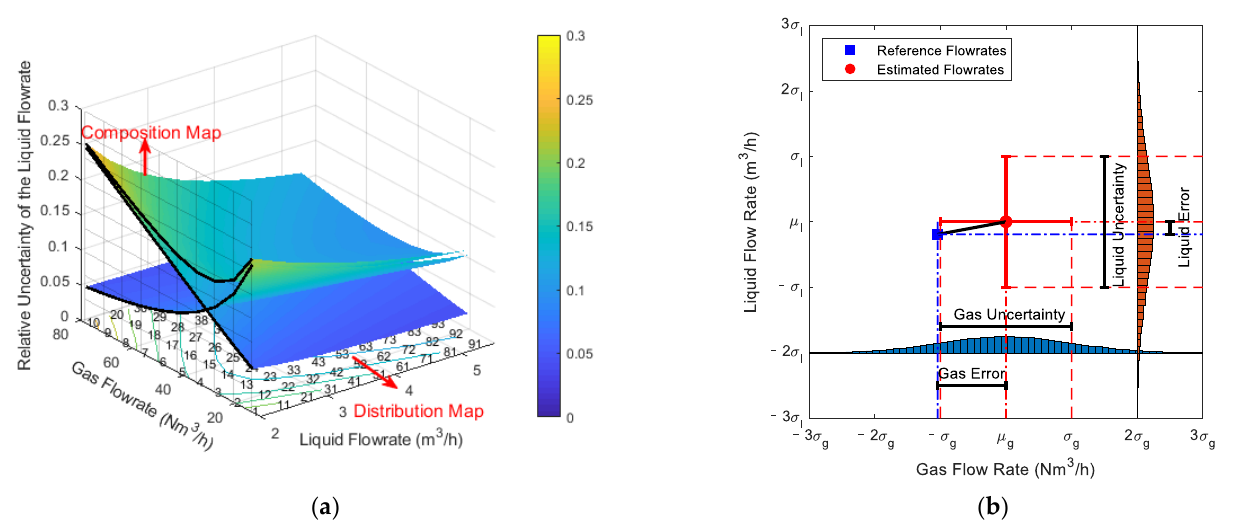
Figure 3. Schematic diagrams of the relationships between certain concepts: ( a ) the relationship between the composition and distribution diagrams; ( b ) the relationship between the error and uncertainty.